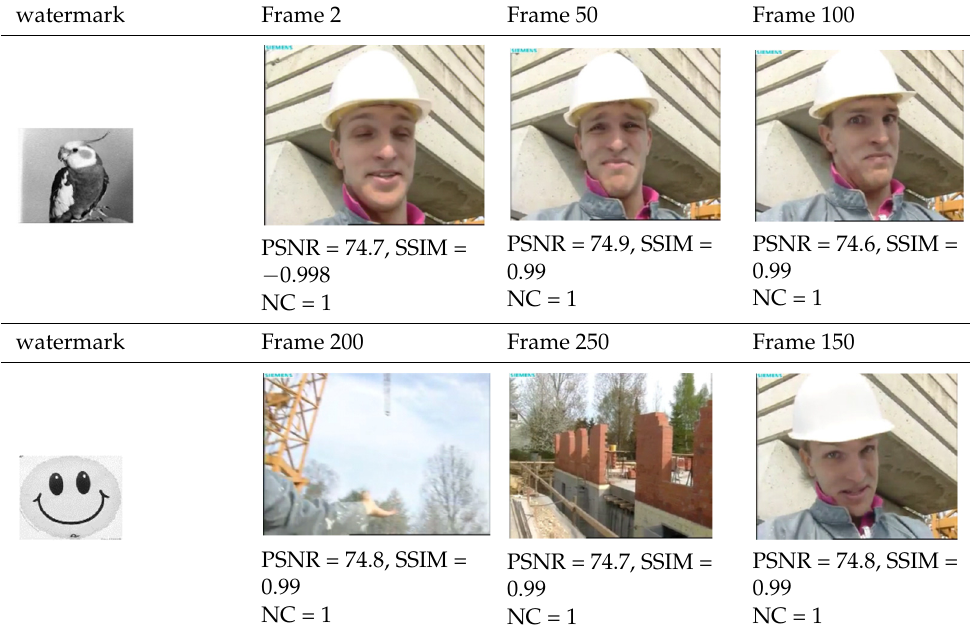
Table 3. PSNR, SSIM, and NC of watermarked “Foreman.mp4”.